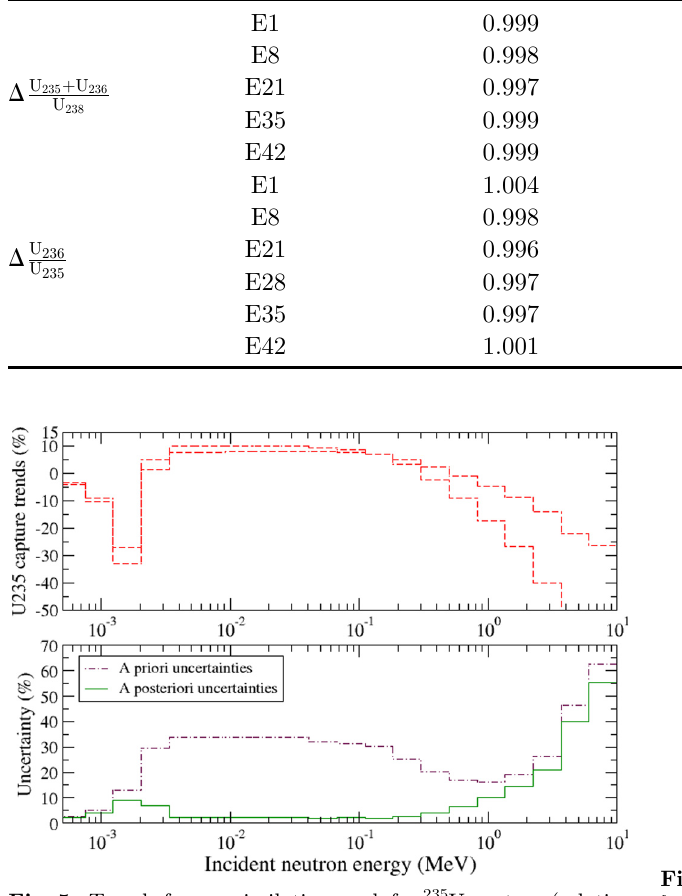
Fig. 5. Trends from assimilation work for 235 U capture (relative to JEFF-3.1.1) compared with a priori and a posteriori nuclear data uncertainties. The two red dotted curves represent an envelope gathering all the trends suggested by assimilation results (that includes cases with fi ssion spectra fi tted or not, and with graphite evaluation from JEFF-3.1.1 or JENDL-4.0).